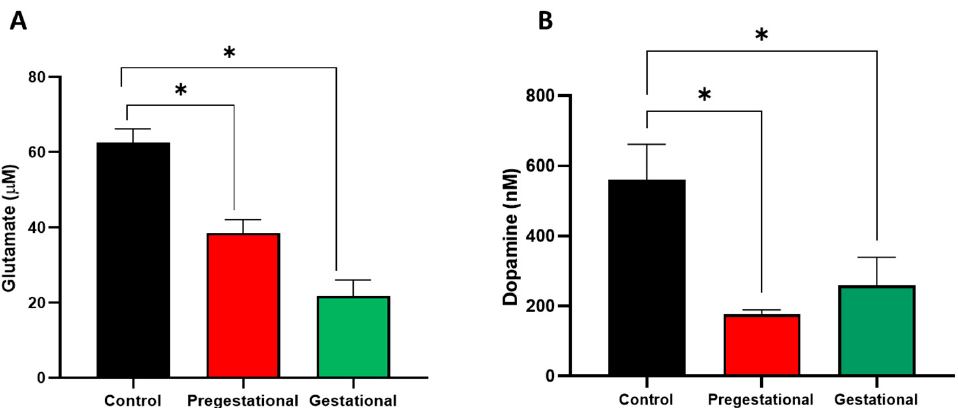
Figure 4. Effect of maternal exposure of T. gondii lysate on cortical neurotransmitters levels in offspring. The cortical levels of ( A ) glutamate and ( B ) dopamine were evaluated in the three experi- mental groups at PND 60 (PBS: control, Pregestational: the progeny of females immunized before pregnancy and Gestational: the progeny of mothers exposed to T. gondii lysate on gestational day 18). Data represent mean ± S.E.M. of 12–15 animals per group. Kruskal-Wallis followed by Dunn’s test, * p < 0.01.